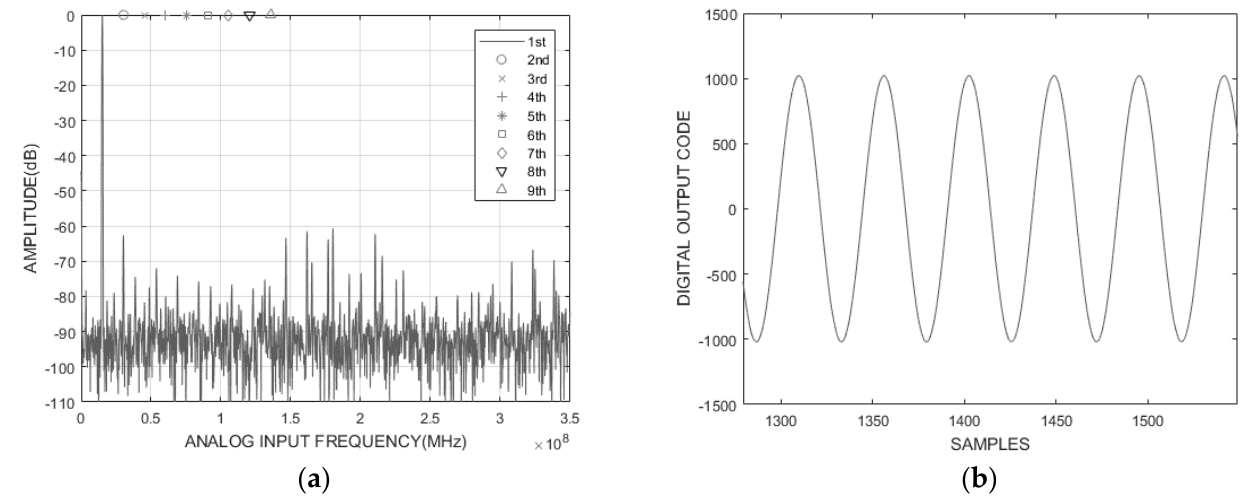
Figure 12. ( a ) Spectrum diagram after sinc interpolation and linear interpolation; ( b ) Time waveform after sinc interpolation and linear interpolation. Table 4. Performance table for overall interpolation.